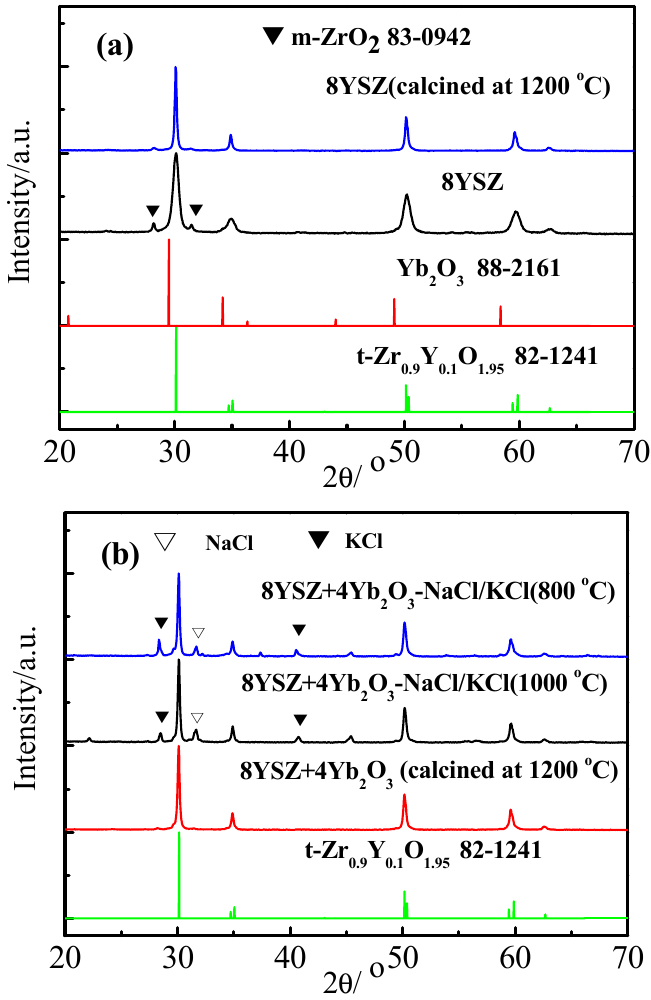
Figure 1. ( a ) XRD patterns of the 8YSZ and 8YSZ (1200 °C) samples. ( b ) XRD patterns of the 8YSZ+4Yb 2 O 3 , 8YSZ+4Yb 2 O 3 -NaCl/KCl (800 °C), and 8YSZ+4Yb 2 O 3 -NaCl/KCl (1000 °C)